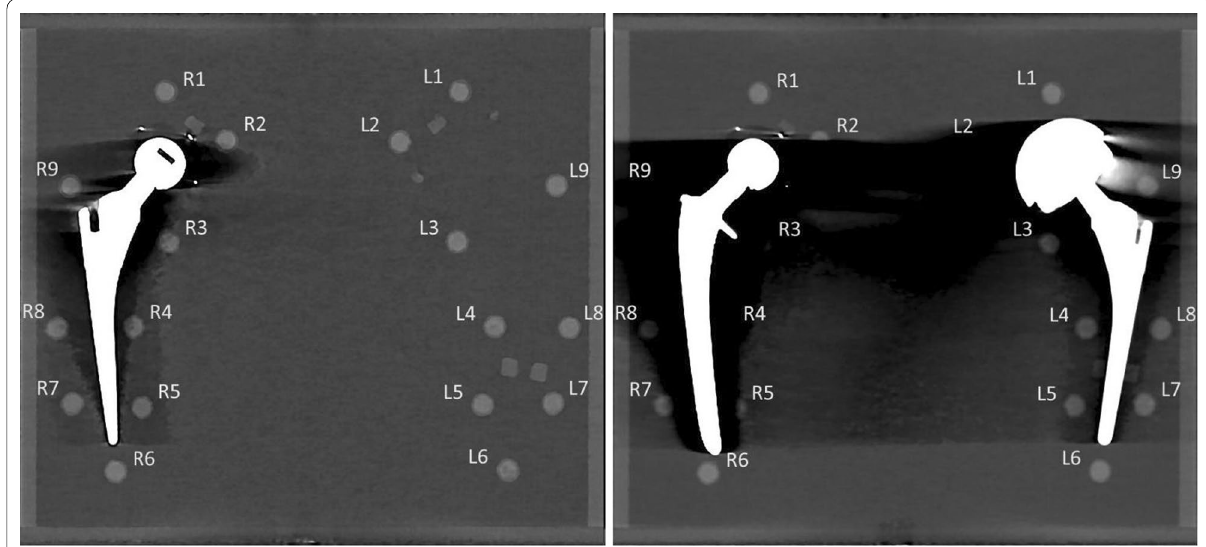
Fig. 2 140 kVp polychromatic images of the phantom. Left image: phantom with unilateral prosthesis at the right (cup: UHMWPE, head: ZTA, stem: TiAlV). Right image: phantom with bilateral prostheses at the right (cup: UHMWPE, head: ZTA, stem: CoCrMo) and left (cup: CoCrMo, head: CoCrMo, stem: TiAlV). UHMWPE ultrahigh molecular weight erthylene, ZTA Zirconia toughene aluminum, TiAlV titanium–aluminum–vanadium, CoCrMo